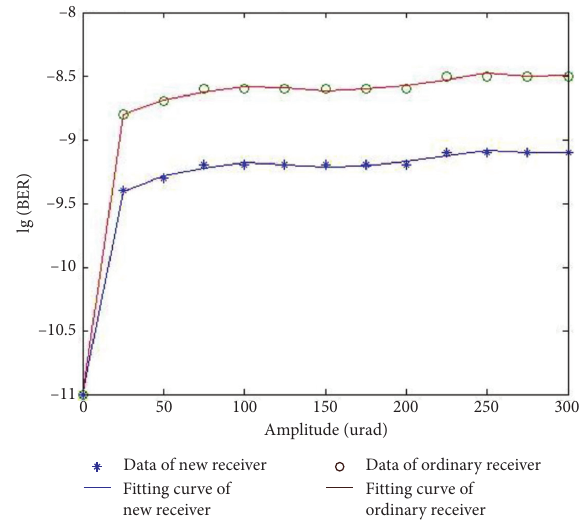
Figure 7: lg(BER) of both new and ordinary receivers (frequency: 50Hz).